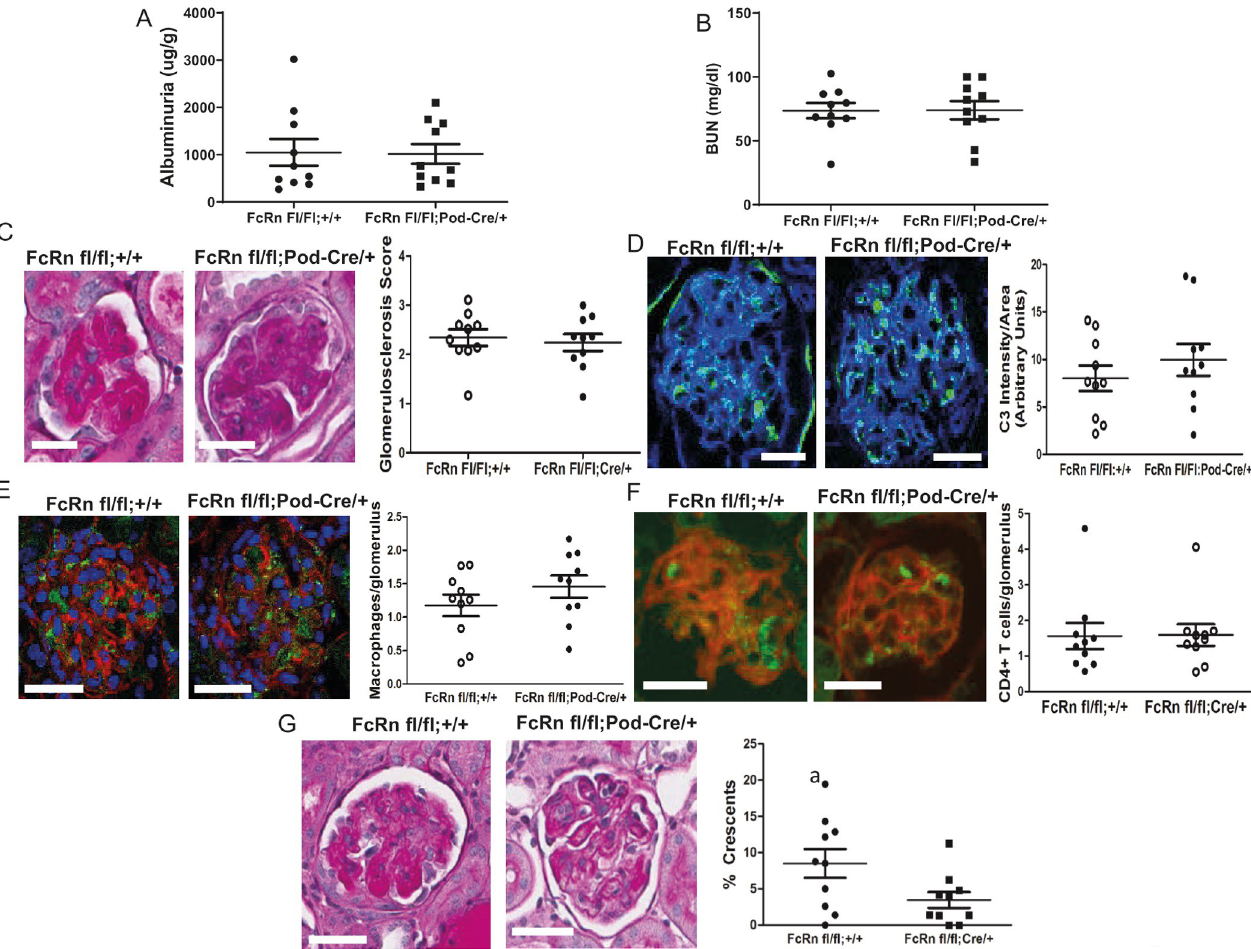
Fig 4. Podocyte specific KO of FcRn results in a significant decrease in glomerular crescents 8 days after anti-GBM disease induction. A , Urine albumin to creatinine ratios in control and podFcRn KO mice (n = 10 control and n = 10 podFcRnKO mice per group). B , BUN in control and podFcRn KO mice. (n = 10 control and n = 10 podFcRnKO mice per group). C , Left panel: representative images of histology in control and podFcRn KO and control mice at day 8. Scale bar 20 μ m. Right panel: Glomerulosclerosis score in control and podFcRn KO mice (n = 10 control and n = 10 podFcRnKO mice per group). D , Left panel: representative images of C3 staining (green) in control and podFcRn KO mice 8 days after anti-GBM disease induction. Actin is stained blue. Scale bar 20 μ m. Right panel: Quantification of C3 intensity normalized for glomerular area in control and podFcRn KO mice (n = 10 control and n = 10 podFcRn KO mice). E , Left panel: representative images of staining for macrophages (green) in control and podFcRn KO mice 8 days after anti-GBM disease induction. Actin is stained red and nuclei are stained blue. Scale bare 20 μ m. Right panel: Quantification of number of macrophages per glomerulus in control and podFcRn Ko mice (n = 10 control and n = 10 podFcRn KO mice). F , Left panel: representative images of glomerular staining for CD4 + T cells (green) in control and podFcRn KO mice at day 8 after anti-GBM induction. Actin is stained red. Scale bar 20 μ m. Right panel: Quantification of CD4+ cells per glomerulus in control and podFcRn KO mice (n = 10 control and n = 10 podFcRnKO mice per group). G , Left panels: representative images of crescents in control mice. Middle Panels: representative images of crescents podFcRn KO mice shown at low and high power. Scale bar 20 μ m. Right panel: Percentage of crescents in control and podFcRn KO mice (numbers of mice are same as in C). Podocyte-specific KO of FcRn results in a significant decrease in the number of crescents (a, p =